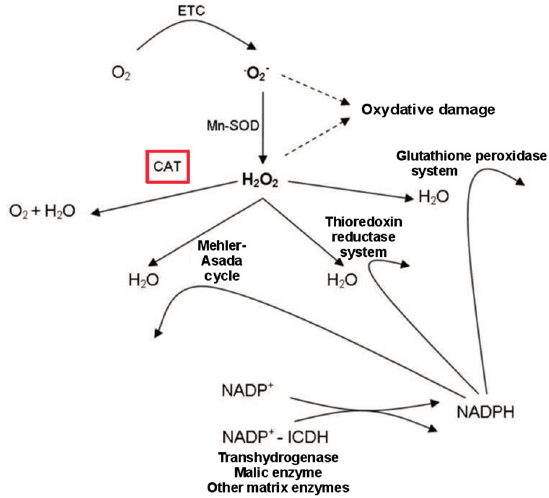
Figure 2. Scavenging of reactive oxygen species (ROS) in plants subjected to abiotic stresses, showing the key role of CAT in ROS scavenging patterns. ETC = electron transport system; ICDH = isocitrate